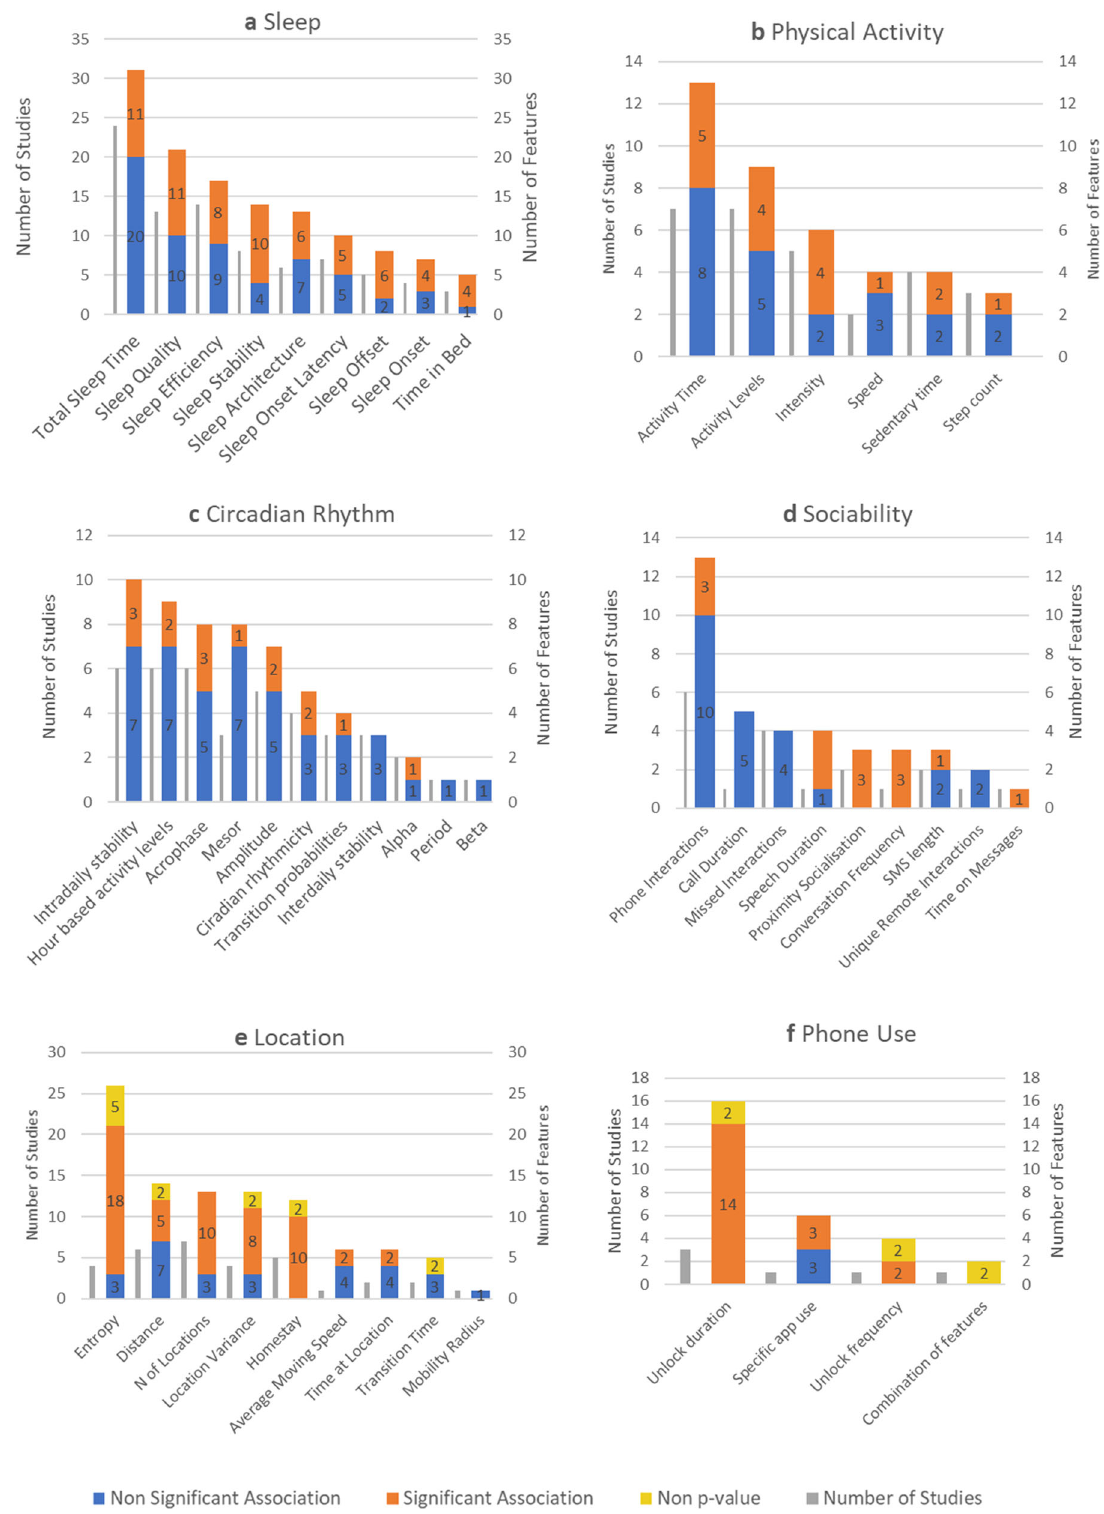
Fig. 4 Feature associations with depression by behaviour type. The number of times each feature ( a sleep, b physical activity, c circadian rhythm, d sociability, e location and f phone use) has been reported in all included studies and their association with depression, where these associations are de fi ned as having a below-threshold p -value ( “ Signi fi cant Association ” ), above-threshold p -value ( “ Non-Signi fi cant Association ” ), and where statistical methods have been used that do not yield p -values ( “ Non- p -value ” ). The graphs also show the number of studies assessing each